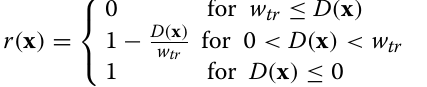
Table 1 The difference between internal forces generated by two RK shape functions with different support sizes in a one‑dimensional stressed rod, where a denotes the RK normalized support size Stress Internal forces Difference (%) a = 3.0 a = 1.5 x 0.16039 − 0.00452 0.00599 176 x 2 − 0.01140 x 3 − 0.00111 0.00031 x 4 −